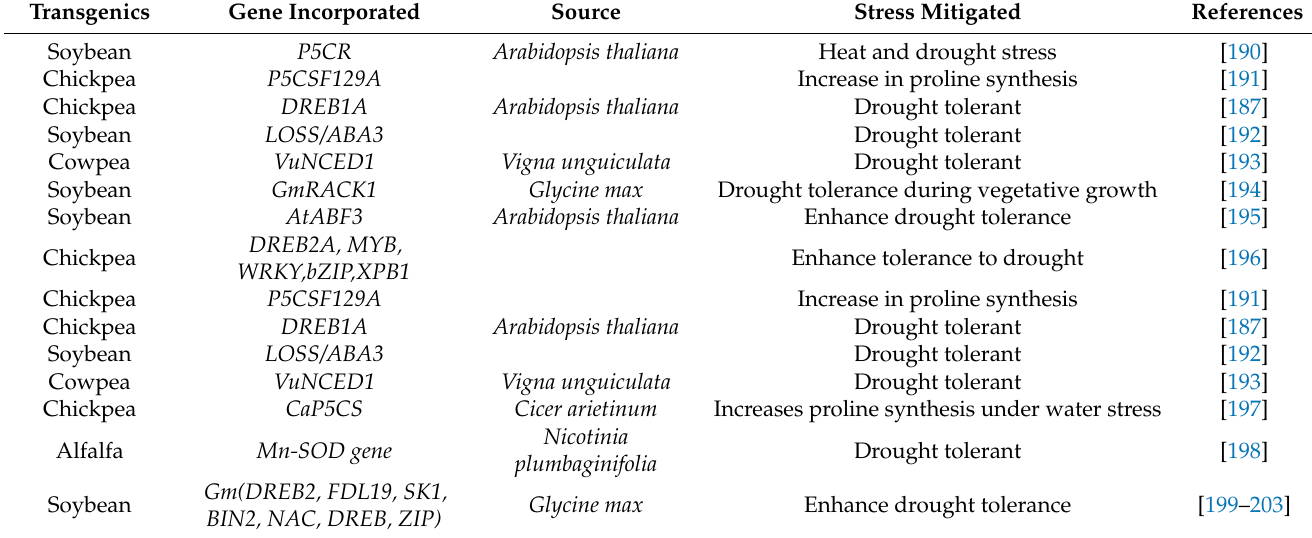
Table 5. Abiotic stress resistance in